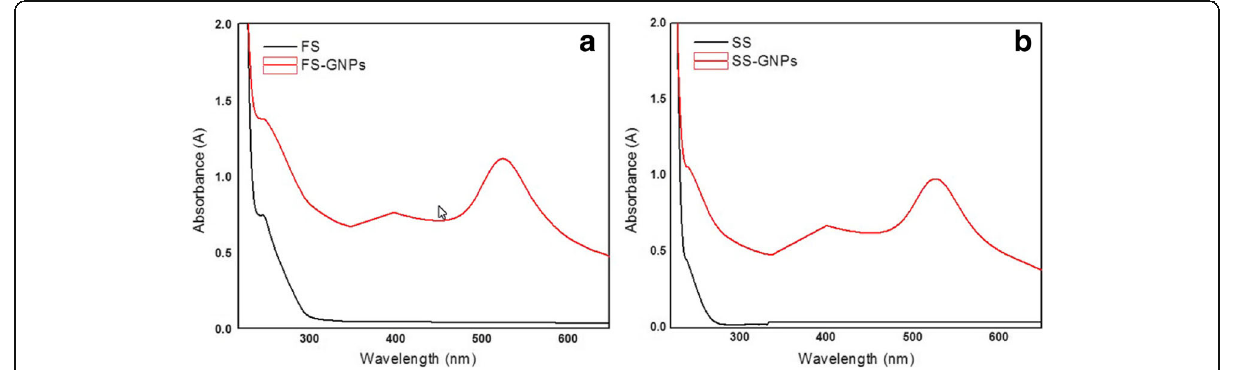
Fig. 6 UV – Vis spectra of a FS, FS – GNPs and b SS, SS –